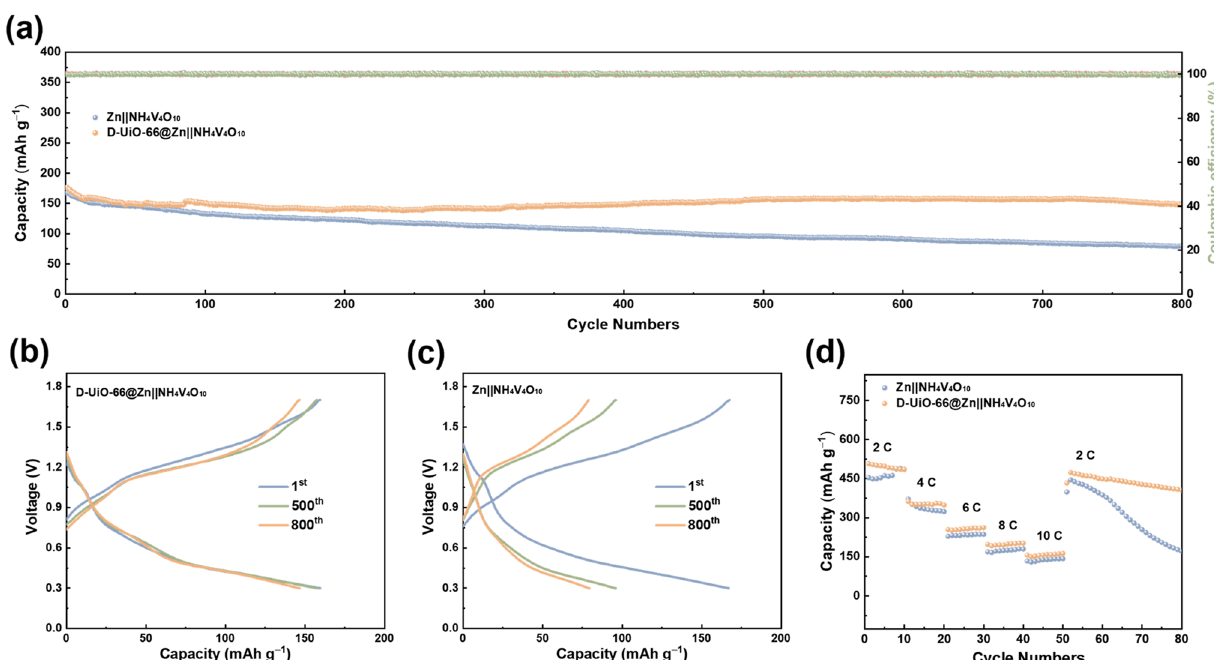
Fig. 6 Performance of Zn||NH 4 V 4 O 10 full cells. a Long-cycling performance and corresponding discharge profiles of Zn||NH 4 V 4 O 10 full cells b with and c without D-UiO-66-based quasi-solid interphase. d Rate performance of Zn||NH 4 V 4 O 10 full cells with and without D-UiO-66-based quasi-solid